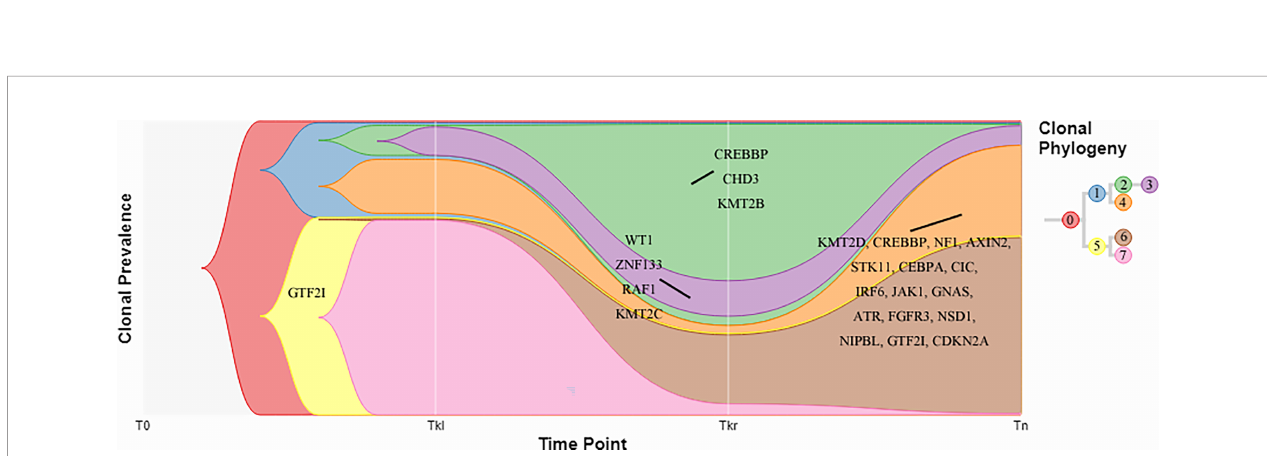
FIGURE 5 | Fish plots constructed by timescape. Colors indicate different clones. Driver genes detected in the clones are shown. Tkl, left kidney tumor; Tkr, right kidney tumor; Tn, neck